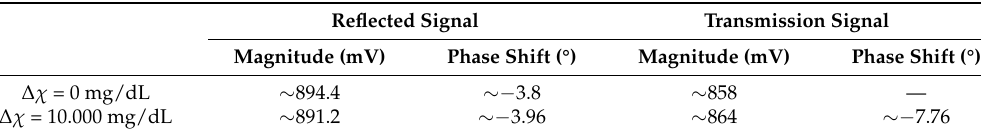
Table 4. Output magnitude and phase shift of reflected signal and transmission signal according to the results of [93].